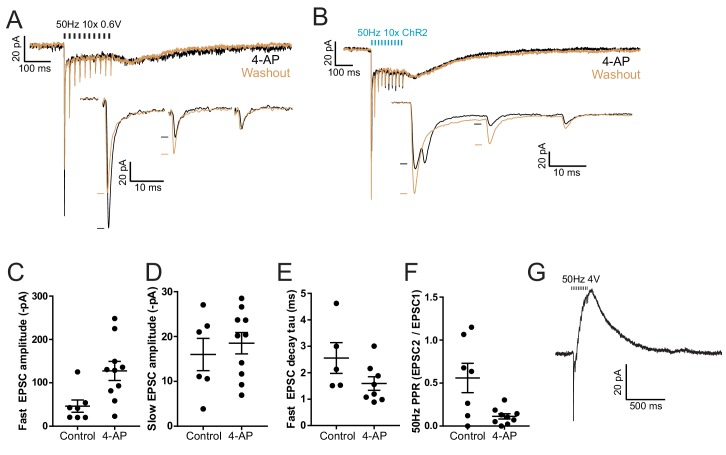
4-AP has effects on the ChR2-evoked EPSC, but does not change whether the UBC response is ON or OFF type.(A) Example of response to electrical synaptic stimulation in 50 μM 4-AP (black) and after washout of 4-AP (brown). Inset shows the first 3 EPSCs in the train with a longer time base. 4-AP increases the amplitude of the EPSC, increases synaptic depression but has no effect on the recurrent slow EPSC that occurs at the offset of stimulation in ON UBCs. (B) In a different ON UBC, 4-AP washout had an effect on ChR2 evoked currents. In 4-AP, release was asynchronous. After washout the release became synchronous. In this cell and one other this asynchronous release was observed in 4-AP and changed after 4-AP washout. (C) The first ChR2 evoked fast EPSC amplitude was larger for cells that had 50 μM 4-AP in the bath. (D) Importantly, the slow EPSC at the offset of the stimulus train that is diagnostic of ON UBCs was inward whether or not 4-AP was present. (E) Decay of the first EPSC in the train with and without 4-AP. (F) Paired pulse ratio was lower in most cells in the presence of 50 μM 4-AP. (G) OFF UBC responses could be evoked by electrical stimulation in these Glt25d2::ChR2-EYFP slices with 4-AP present, indicating that the lack of OFF UBC responses evoked by primary fiber activation was not due to non-specific block of GIRK or mGluR2 or to the absence of OFF UBCs in this mouse line.